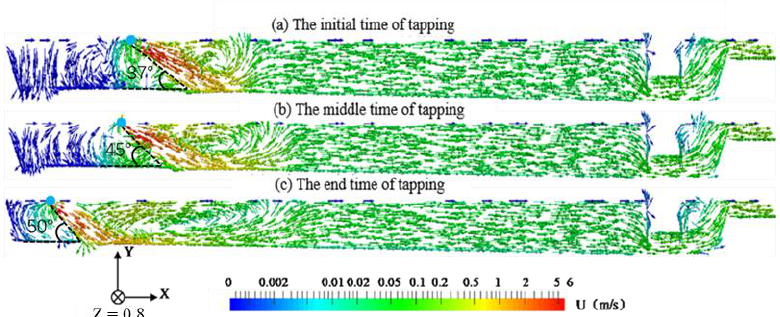
Figure 5. Velocity distribution of hot metal on the center plane (cf. Figure 4) at three different time points.